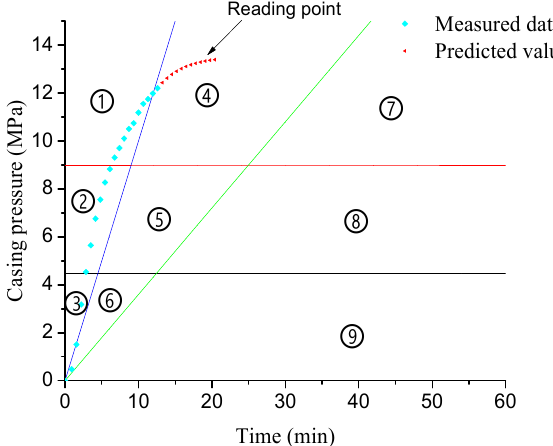
Figure 18. Results of the kick severity analysis using the predicted casing pressure.